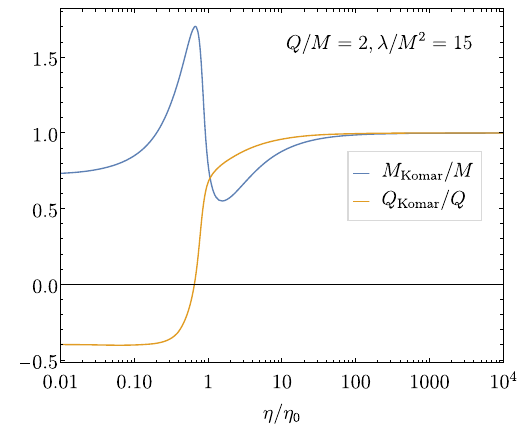
Fig. 7 Same as Fig. 5 for Q / M = 2 and λ/ M 2 = 15